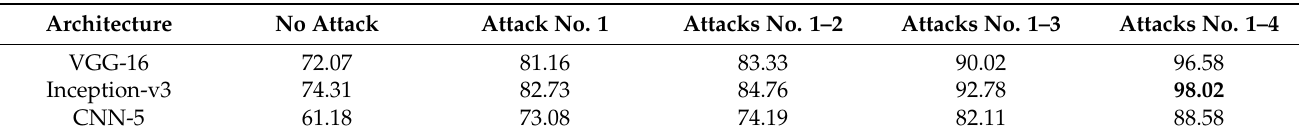
Table 7. Percentage of correct MNIST.DIGITS image recognition with prevention of visual attacks and reduction of dimen- sion.